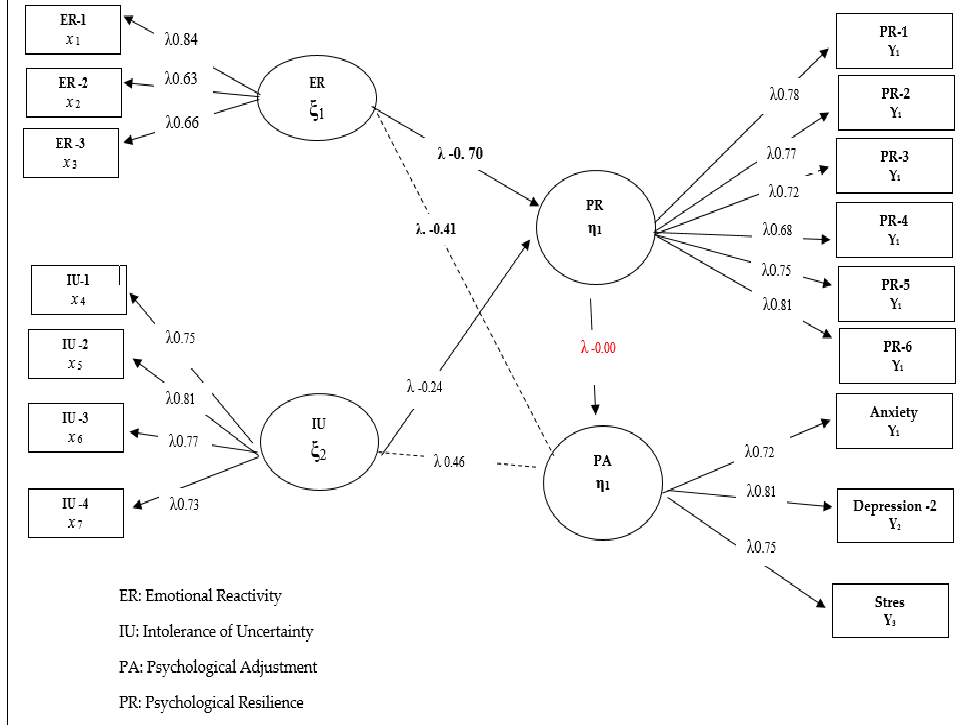
Figure 2. Standardized SEM results for Model 2. (Figure S2).